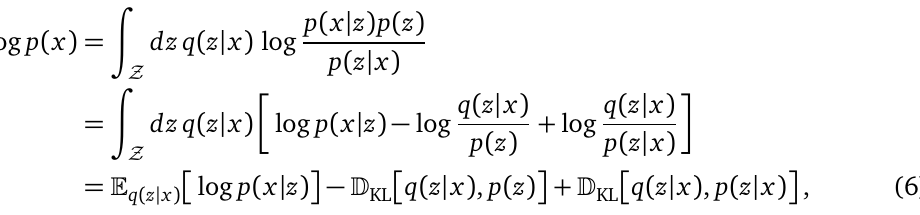
) after which 0 , for which 0